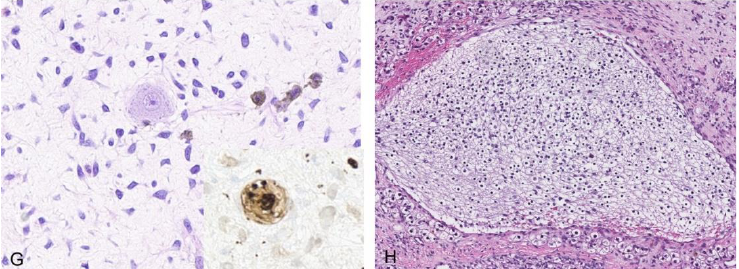
Figure 1. Rhabdomyoblastic differentiation, neuroglia, and melanin in teratoid HB. ( A ) Rhabdomyoblastic differentiation in THB14 (H&E 10x). ( B ) Desmin IHC in THB14 10x. ( C ) Melanin in association with squamous differentiation with post-therapy effects in THB21 (H&E 4x). ( D ) Iron stain in THB21 10x. ( E ) Mature neuroglial elements in THB14 (H&E 10x). ( F ) GFAP IHC in THB14 10x. ( G ) Ganglion cells in THB14 (H&E 20x) and PGP9.5 IHC in THB14 20x (Inset). ( H ) Mature neuroglial elements in THB18 (H&E 10x).